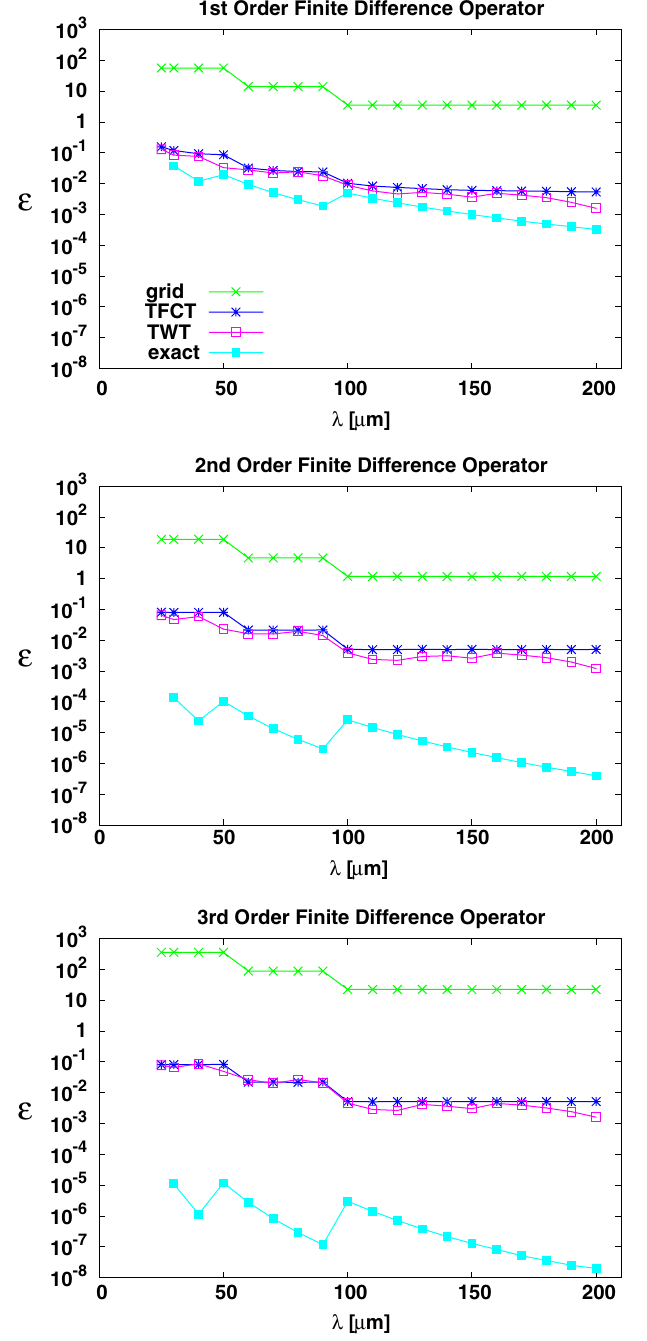
FIG. 23. The same as Fig. 12, only with the finite difference schemes (Table V) applied to the exact distribution (light blue line): 1st order (top), 2nd order (middle), and 3rd order